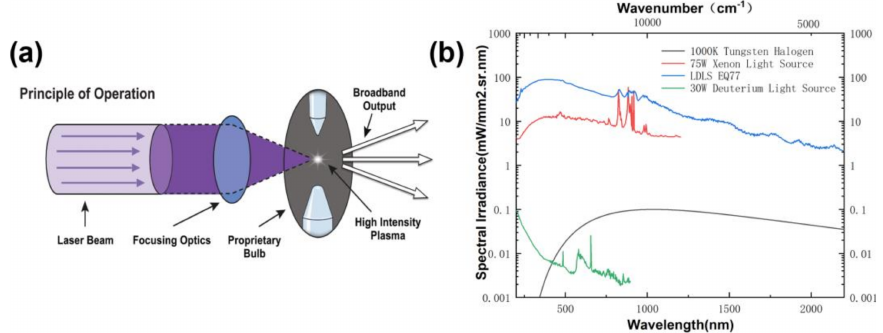
Figure 1. Laser-driven light source. ( a ) The working principle and structure of the LDLS, and ( b ) comparison of the spectral range and spectral irradiance of common light sources in VIS − NIR spectroscopy